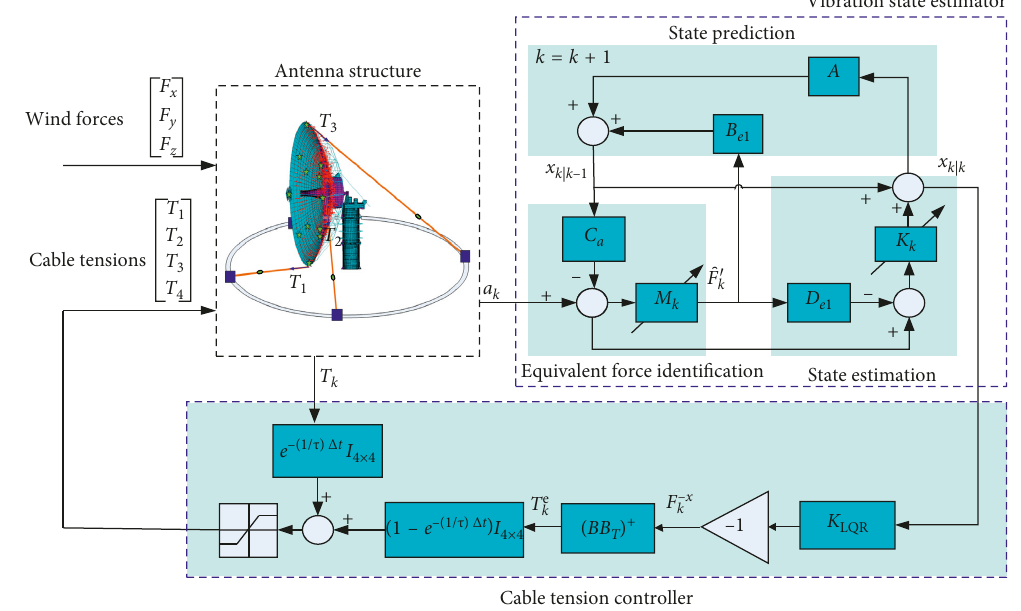
Figure 7: Adaptive system to suppress transient wind disturbance.